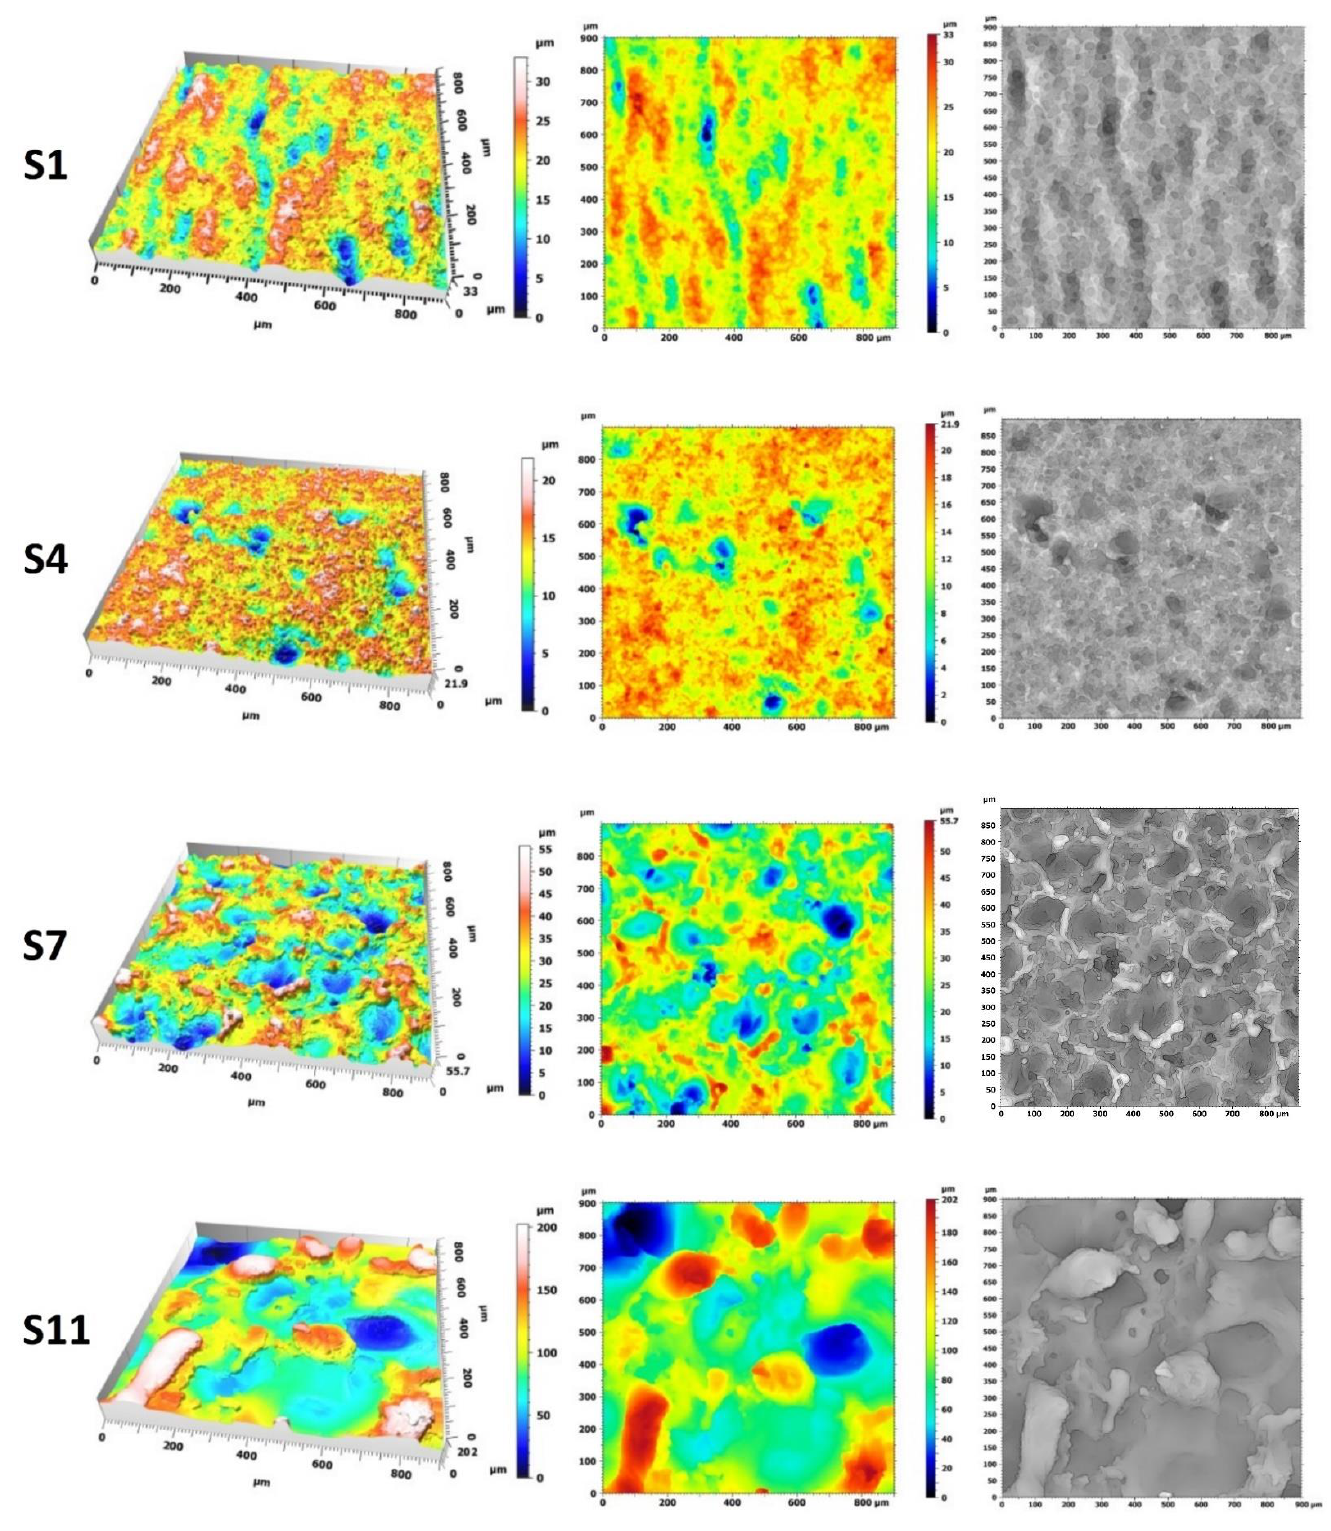
Figure 2. Results of areal measurements of representative locations on surfaces S1, S4, S7, and S11. 3D render of raw surface morphology ( left column ), 2D view of raw surface morphology ( middle column ), and raw surface morphology with highlighted topographical features ( right column ) .